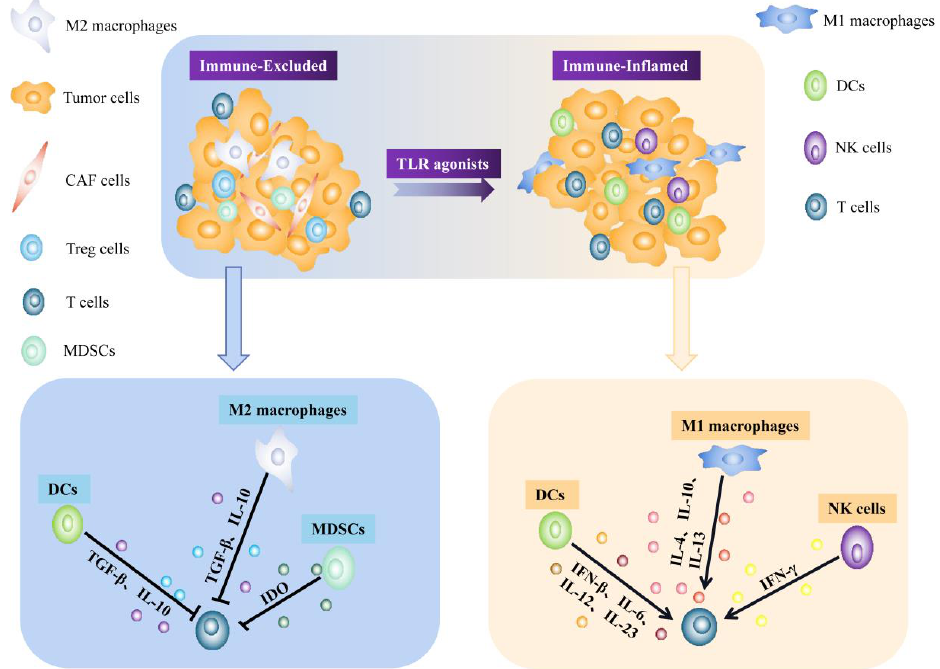
Figure 2. Reprogramming of the immunosuppressive TME by TLR agonists. Immune-Excluded (I-E) TIMEs are characterized by the exclusion of T cells from the tumor core, whereas MDSCs and Treg cells can suppress antitumor immune responses and promote malignant cell growth. And many cancers typically exhibit an immunosuppressive M2-like phenotype, in an anti-inflammatory state. TLR agonists treatment can transform the I-E TIME into an immune-inflamed (I-I) TIME. In the process of this transformation, TLRs activation is able to induce macrophage polarization toward the M1 type. And the cytokine profiles of dendritic cells (IL-6, IL-12, IFN- β and IL-23) and NK cells (IFN- γ ) induced by individual TLR agonists enhance T-cell infiltration and alter the suppressive function of Treg